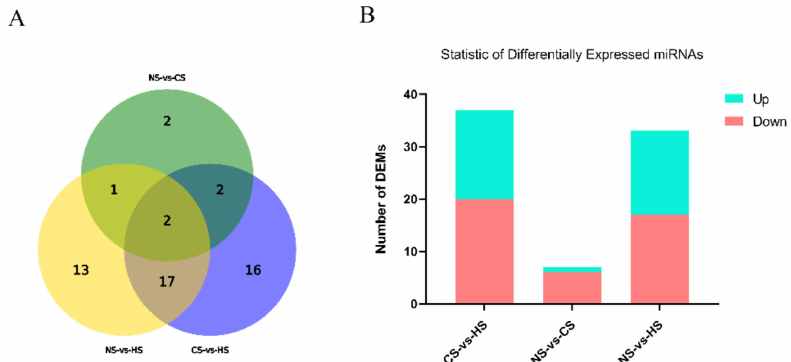
Figure 1. ( A ): Statistics of overlap between di ff erentially expressed miRNAs (DEMs) groups: The circles represented by di ff erent elements represent di ff erent conditions, and the numbers represent the number of di ff erent microRNAs (miRNAs); ( B ): Statistics of DEMs among di ff erent groups: The abscissa represents the comparison between samples, and the ordinate represents the number of significantly DEMs. Red represents up-regulated miRNA, and blue represents down-regulated